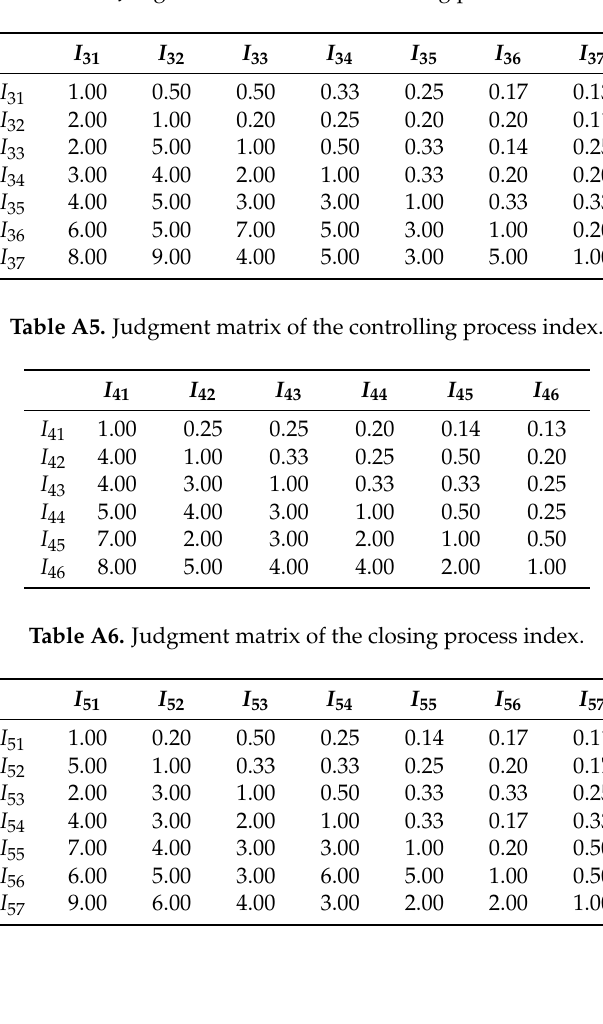
Table A4. Judgment matrix of the executing process index.